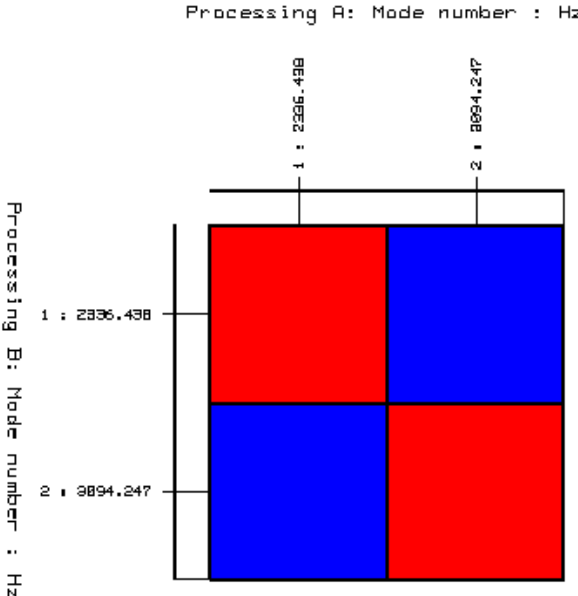
Figure 24. Validation of selected stable poles and the corresponding modes of the free vibrations using the AutoMAC function. (convergence percentage between the modes of on-vibrations determined from the stabilization diagrams: blue = 4%, red